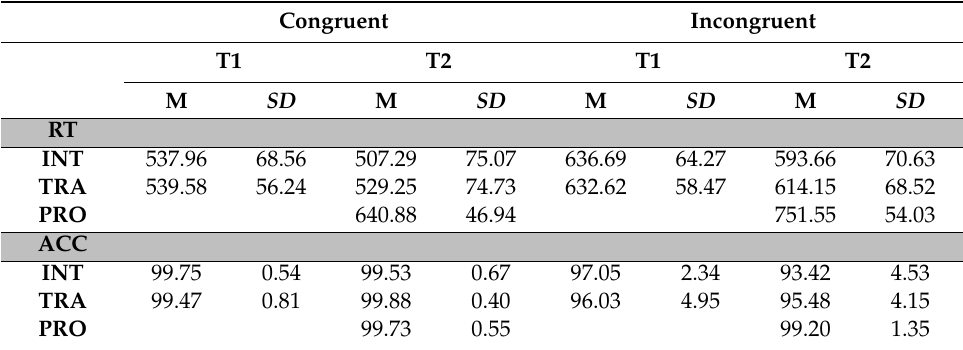
Table 2. Response times and accuracy scores (means, SDs) for the three